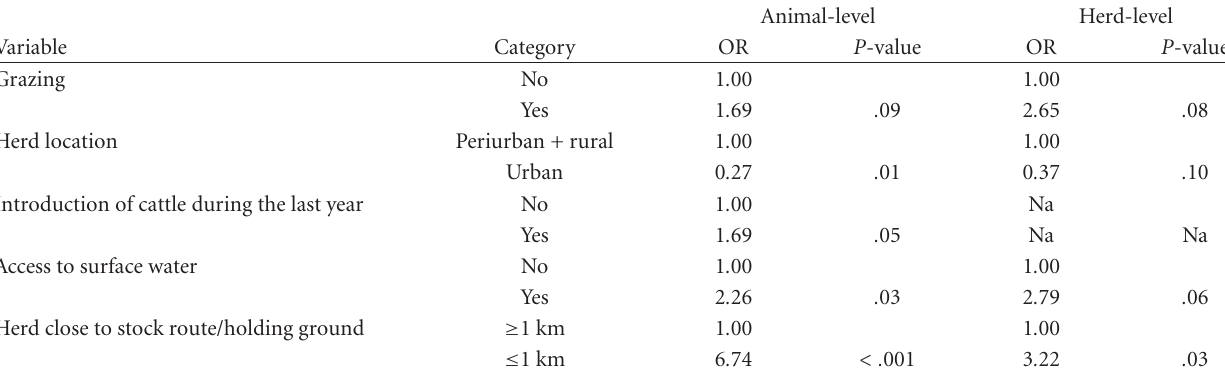
Table 3: Association of antibody to Brucella positives and explanatory variables ( p ≤ . 10) in univariable regression models (May 2003 − January